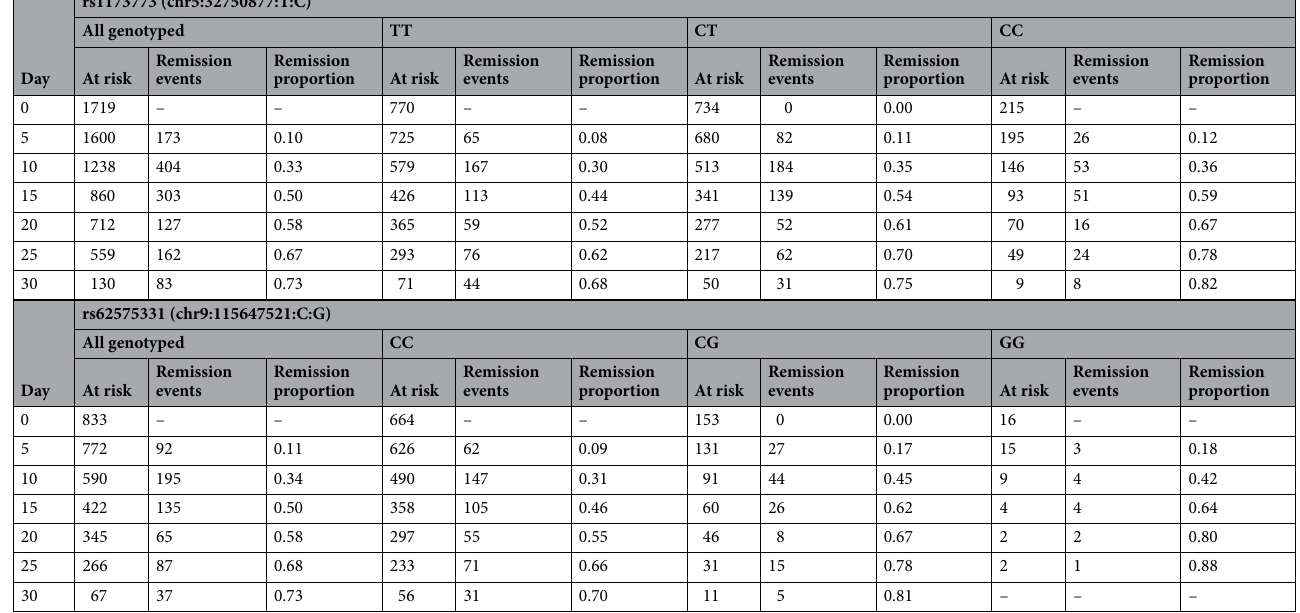
Table 3. Estimated cumulative incidence of COVID-19 symptom remission events by genotype groups. Cumulative incidence estimates were derived from Cox proportional hazards using genotype hard calls with adjustment for age, sex, 10 principal components, and for the analysis of rs1173773, with additional adjustment for study arm. Remission proportion was calculated as 1-symptom persistence probability. Chr: